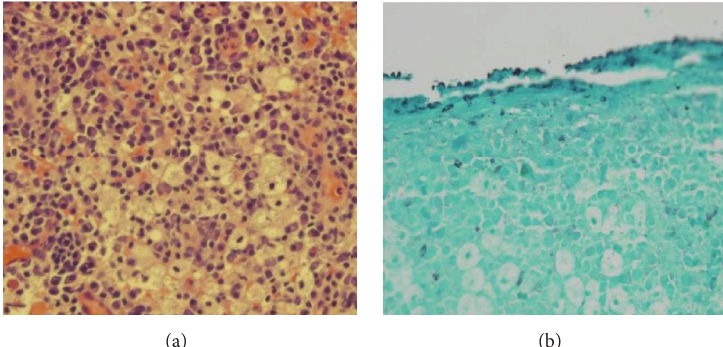
Figure 3: (a) Histopathology showing plasma cell infiltrate mixed with foamy macrophages, known as Mikulicz cells (H&E, 40x). (b) Coccobacilli seen inside the macrophages (GMS,